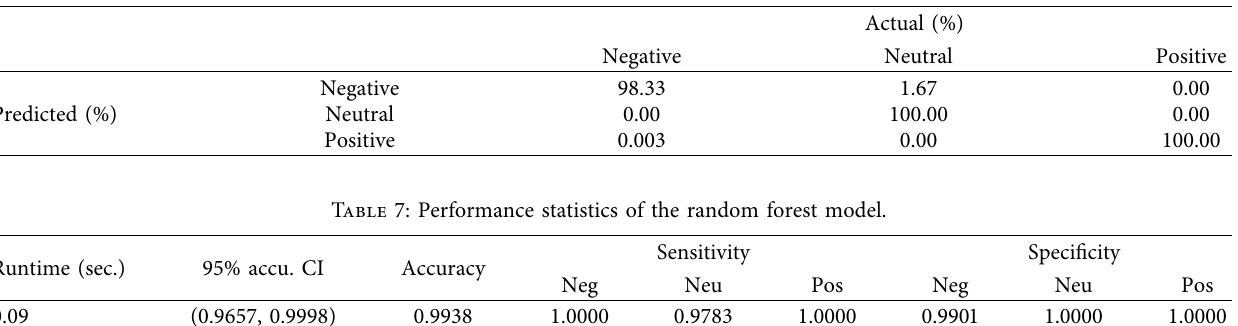
Table 6: Confusion matrix of the Naive Bayes model.